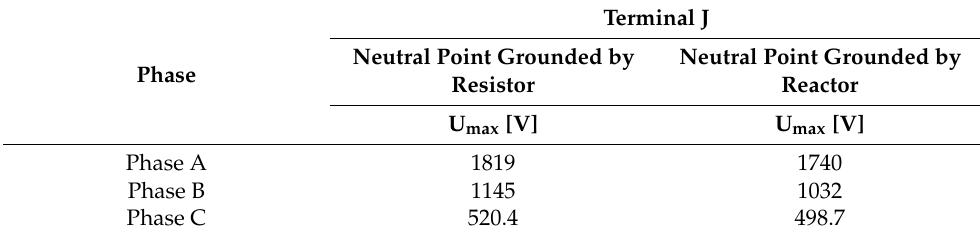
Table 3. Maximum overvoltage for different neutral point grounding